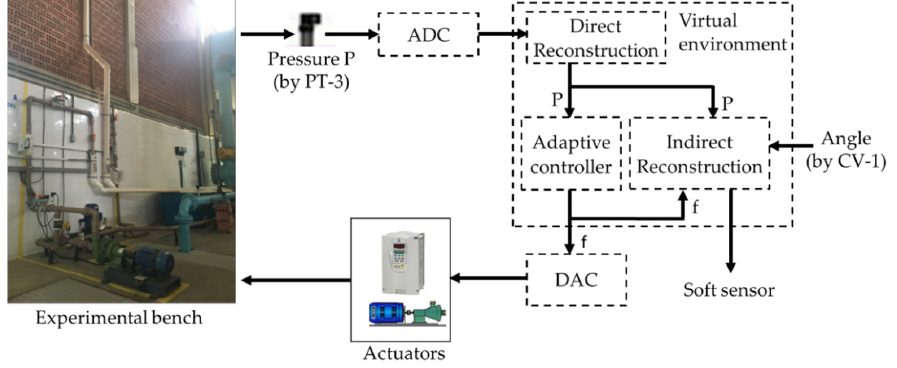
Figure 6. Feedback system for indirect flow measurement.